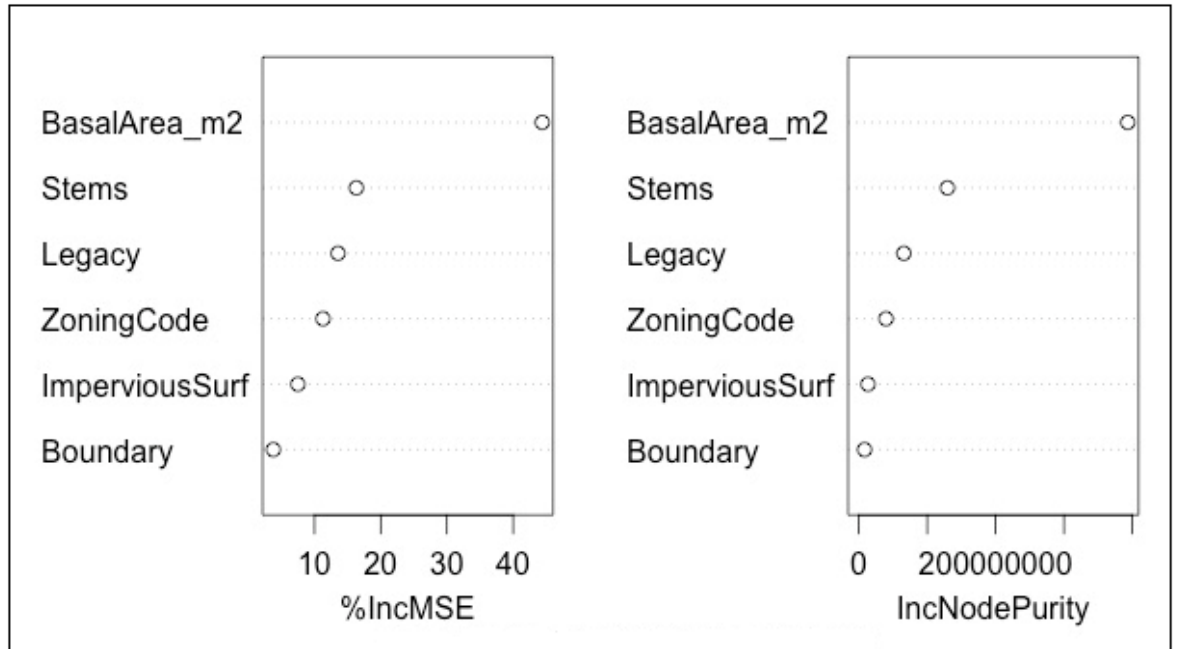
Figure 7. Variable importance for the six variables used in the initial tree. The graphs show that BA is significantly more important for partitioning data on AGTC than the other five variables, followed by stem count.